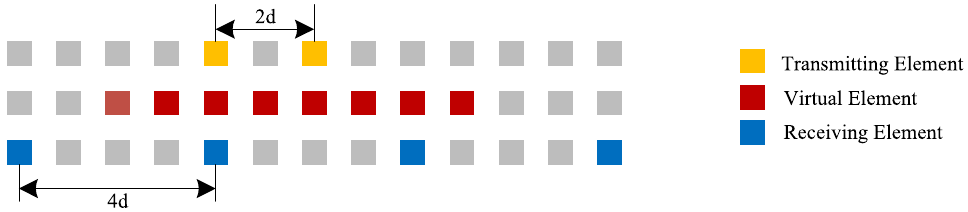
Figure 1. Synthetization of the virtual antenna array.